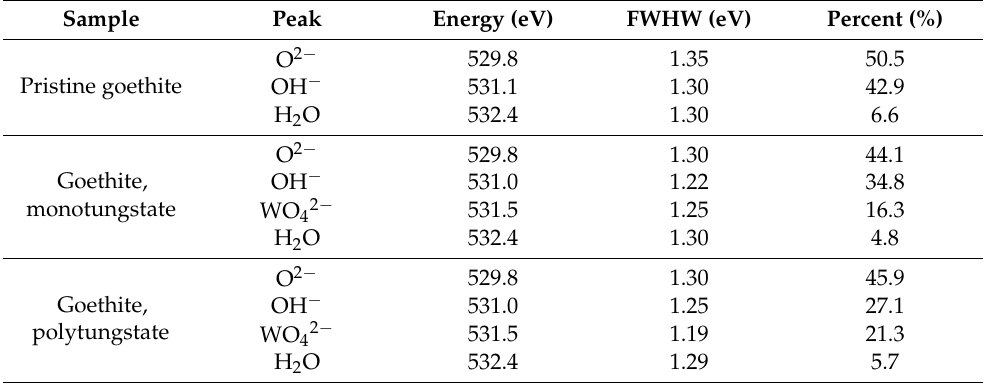
Table 5. Fitting parameters for O1s spectra of pristine and mono/polytungstate-loaded goethite.